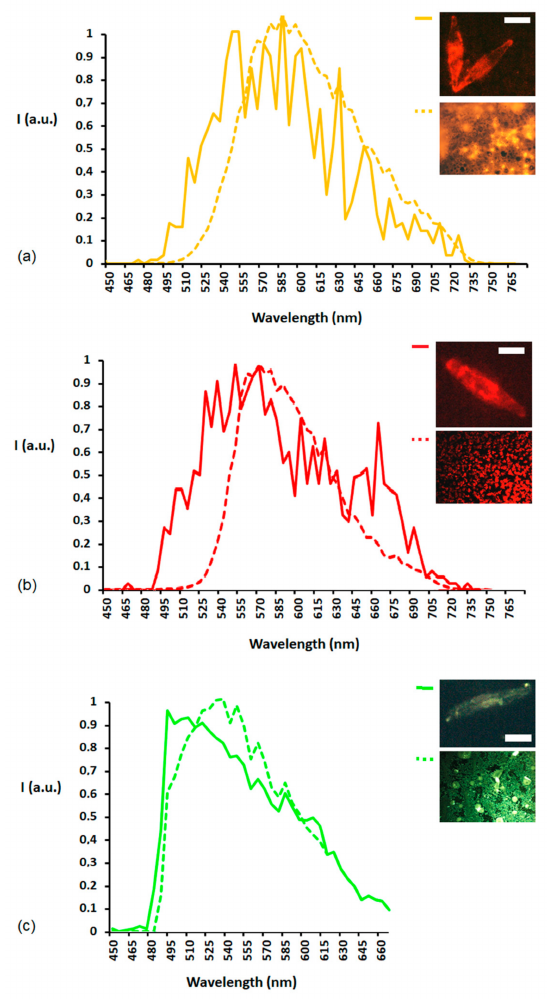
Figure 6. Photoluminescence spectra recorded via confocal microscopy of the following: (continuous line) purified ( a ) Ir-doped, ( b ) Ru-doped, and ( c ) Al-doped valves and (dotted lines) neat films of the relative complexes. Inset images report the analyzed valves (top) and the neat films (bottom) of complexes recorded by bidimensional fluorescence microscopy. Scale bar 10 µ